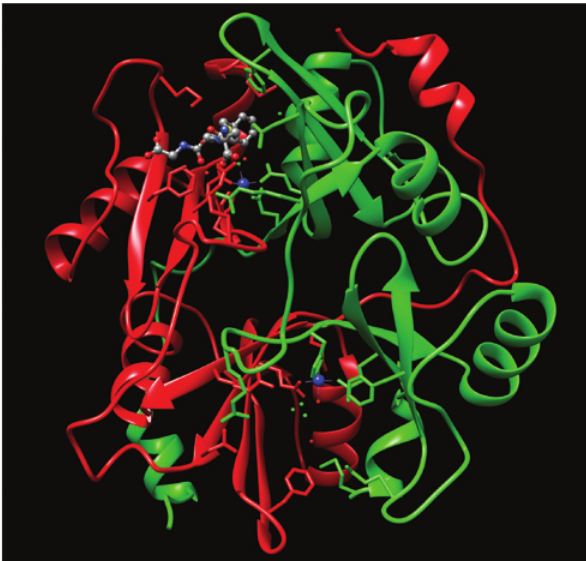
Figure 3: Ribbon representation of H. sapiens glyoxalase I with S-benzylglutathione inhibitor bound to the active site. The two subunits of the enzyme are colored green and red. Active site hexacoordinate Zn 2 + is shown as a blue sphere with amino acid side chains from both subunits contributing to the binding of each active site zinc atom. The inhibitor (in ball-and-stick) is only shown in one active site for clarity. (PDB code: